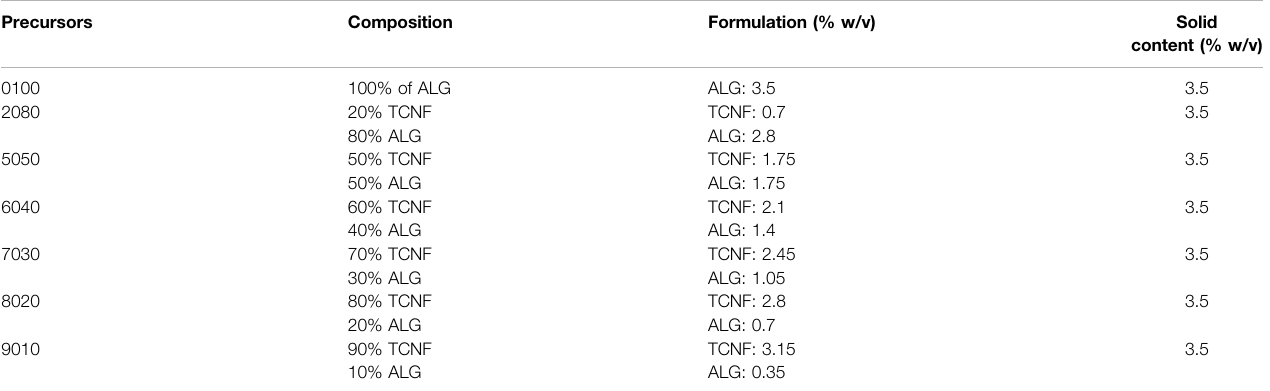
TABLE 1 | TCNF/ALG precursor